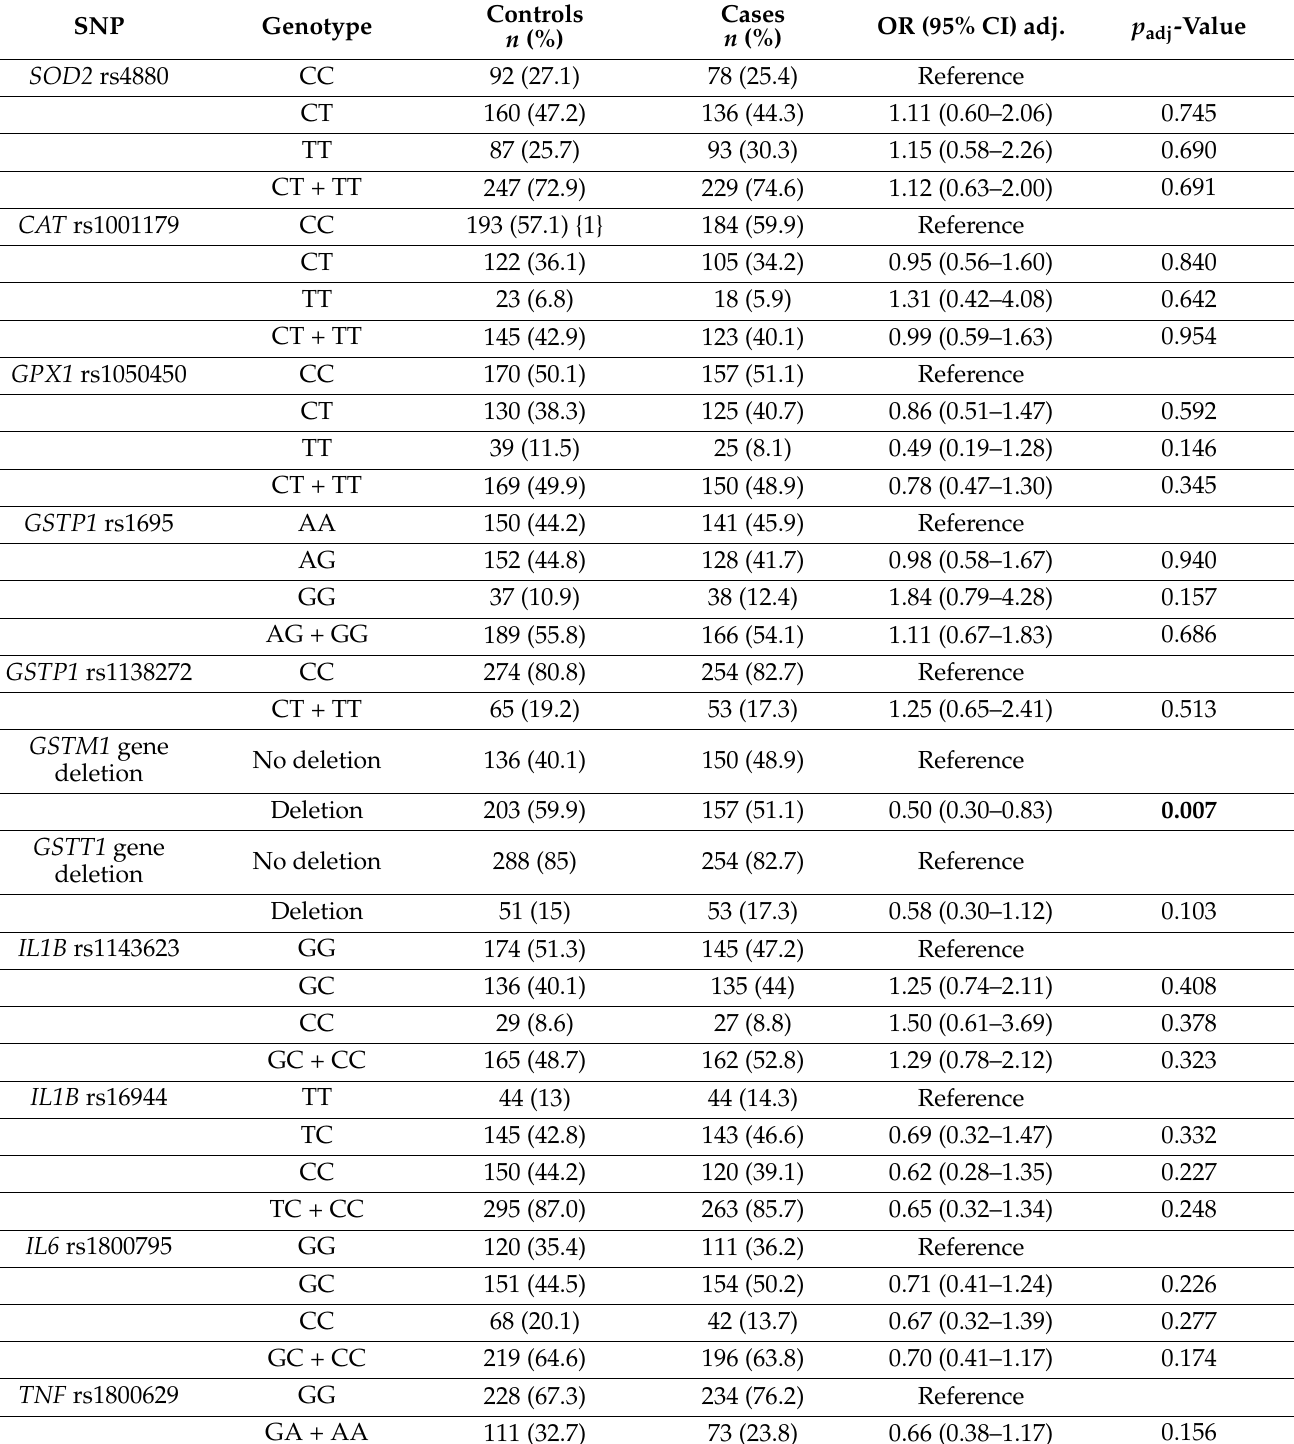
Table 2. Genotype frequencies of the control ( n = 339) and patient ( n = 307) groups with the risk of glaucoma or